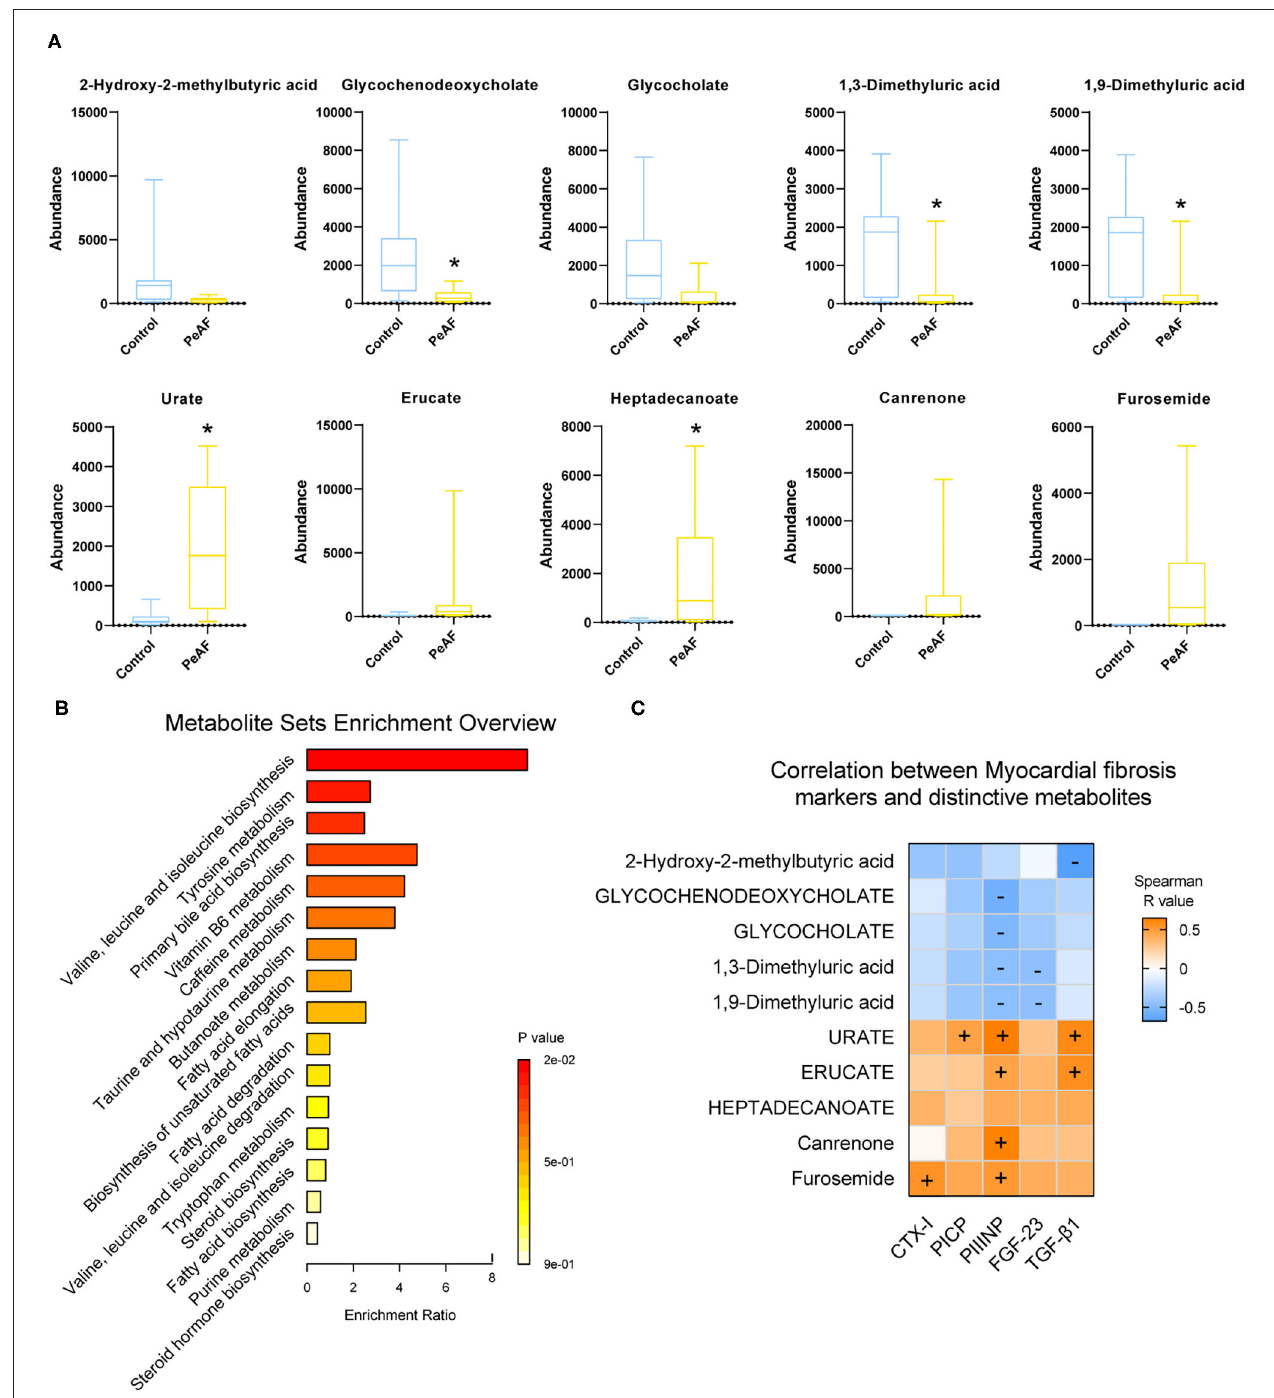
FIGURE 7 | Functional analysis of differential metabolites and their correlation with myocardial fibrosis. (A) The top 5 differential metabolites that decreased and increased the most between control group and PeAF group. *Compared to the control group, p < 0.05. (B) Analysis of KEGG pathways of differential metabolites. (C) Correlation analysis of myocardial fibrosis markers and differential metabolites. “ + ” indicates positive correlation (orange), p < 0.05. “–" indicates negative correlation (blue), p < 0.05.